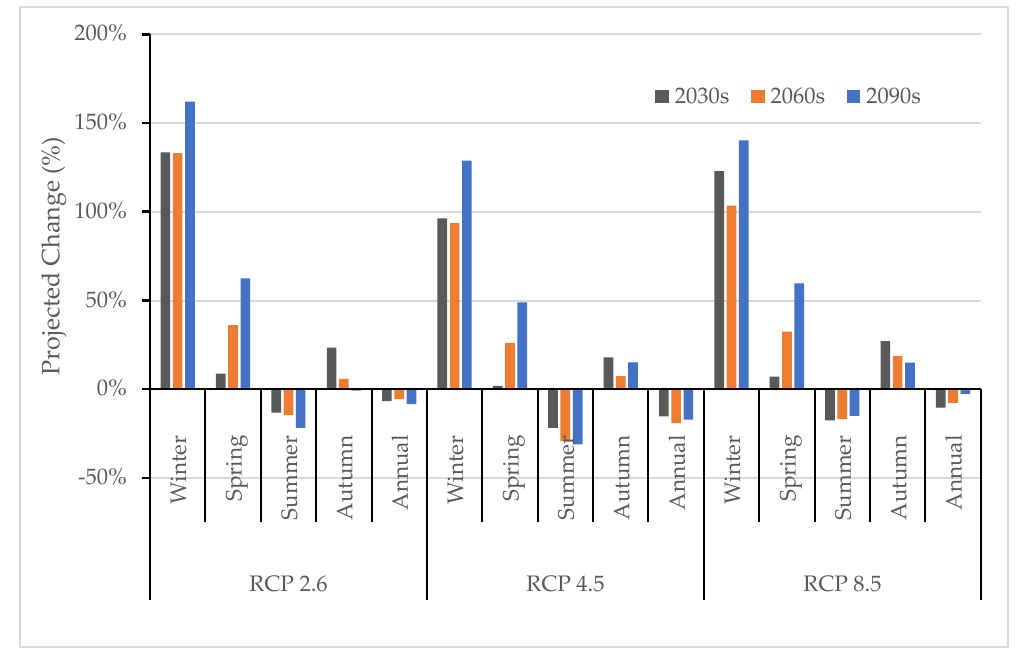
Figure 9. Seasonal change in projected precipitation for the basin compared to the baseline period (1961–2005).